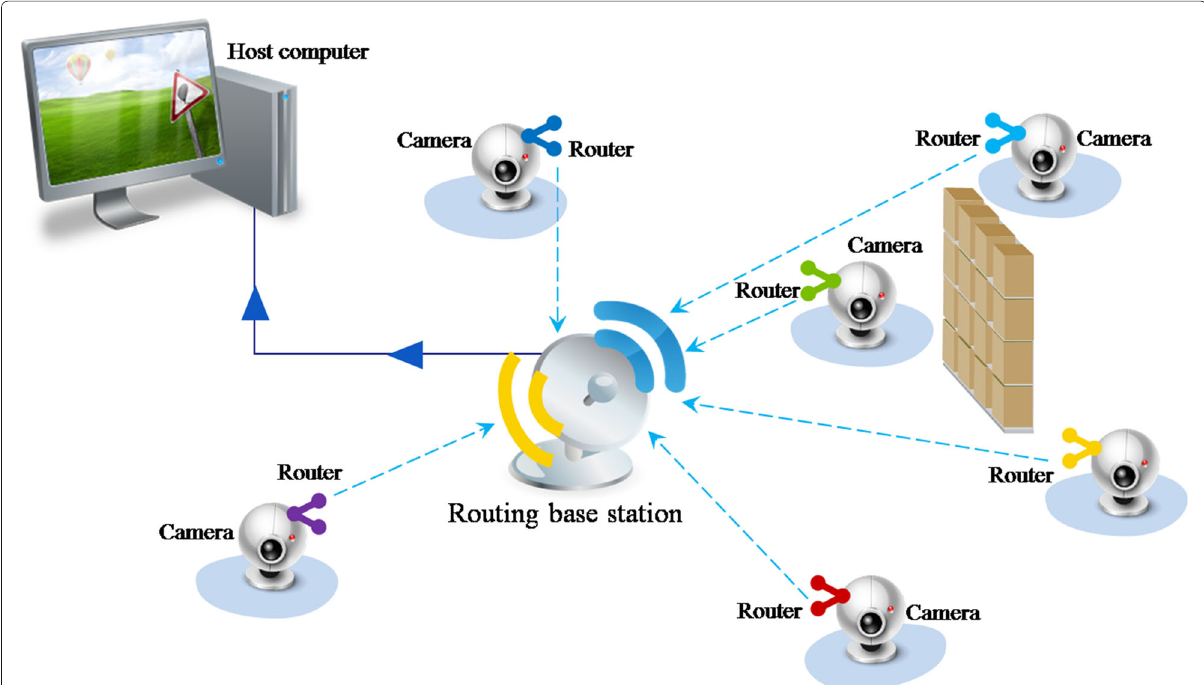
Fig. 3 Hardware frame diagram of security monitoring